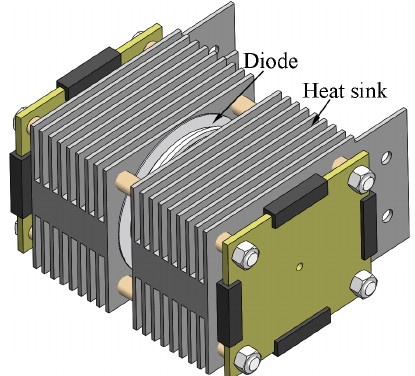
Fig. 2. Radiator combination model of a rectifier cabinet with a circular heating